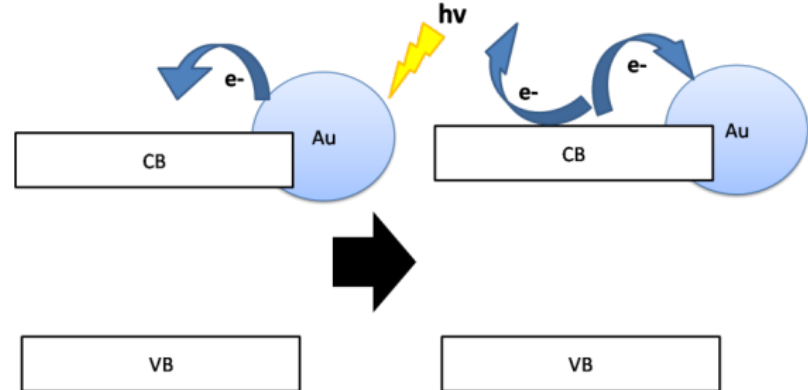
Figure 12. Proposed possible mechanism of the pathway of the hot electrons transferred in Au doped TiO 2 .